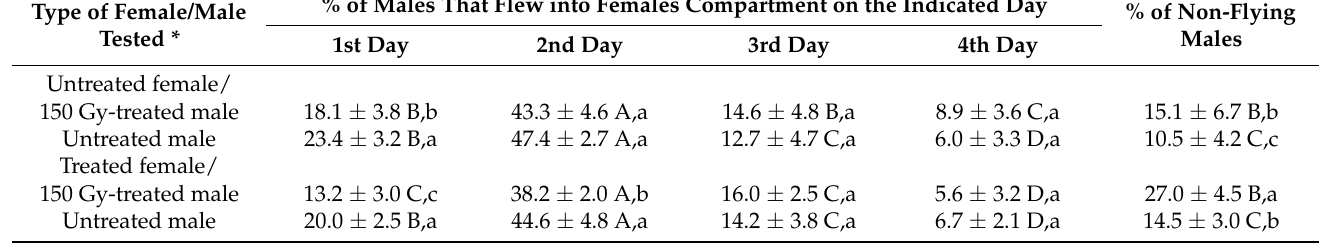
Table 2. Mean percentages ( ± SD) of untreated and 150 Gy-treated Lobesia botrana males succeeding in flying to virgin untreated and 150 Gy-treated calling females in the calling female compartment in a flight assessment cage during 4 successive days. The mean percentages ( ± SD) of males that failed to fly into the female compartment is consigned in the column farthest to the right.